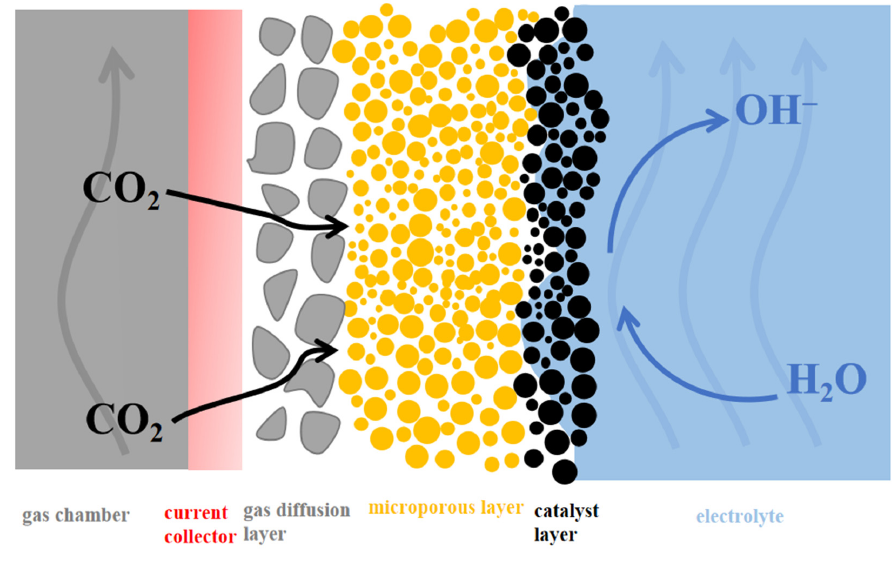
Figure 13. Illustration of catalyst layer on GDE.